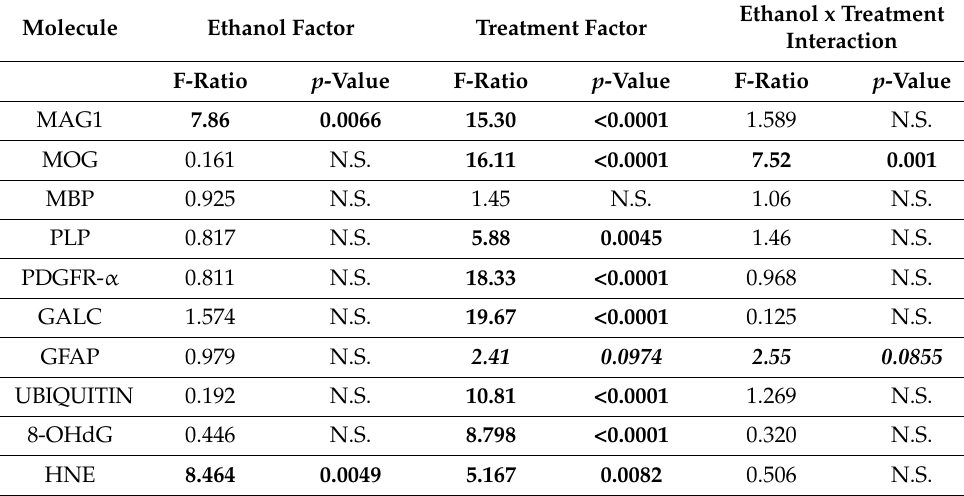
Table 1. Effects of In Vivo Ethanol Exposure and Ex Vivo Interventive Treatments on Glial and Stress Molecule Expression in Frontal Lobe White Matter Slice Cultures. Ethanol x Treatment Molecule Ethanol Factor Treatment Factor Interaction F-Ratio p -Value F-Ratio p -Value F-Ratio p -Value MAG1 7.86 0.0066 15.30 <0.0001 1.589 N.S. 0.161 16.11 5.88 0.0045 1.46 N.S. PDGFR- α 0.811 N.S. 18.33 <0.0001 N.S. GALC 0.192 1.269 N.S.